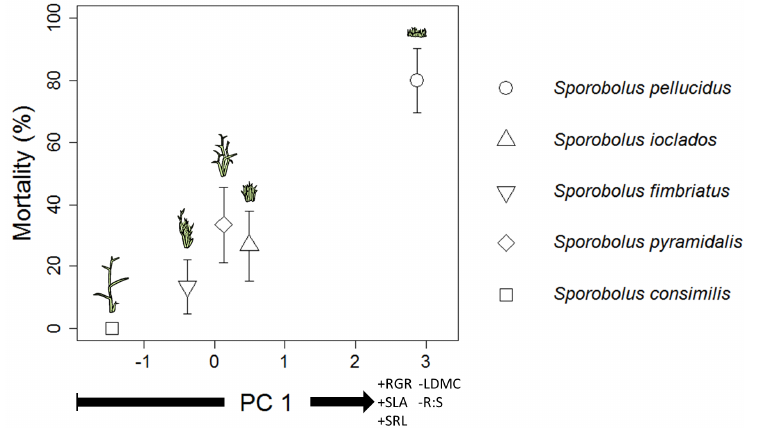
Figure 4. Mortality (±SD of Bernoulli distribution) plotted against PC1 from a PCA of species trait data. Shapes represent different species in the legend, each with a distinctive cartoon. The sign (+ or − ) before the trait name on the x axis indicates its loading onto PC 1 (0.39, 0.48, 0.47, − 0.51, − 0.38 for RGR, SLA, SRL, LDMC, and R:S